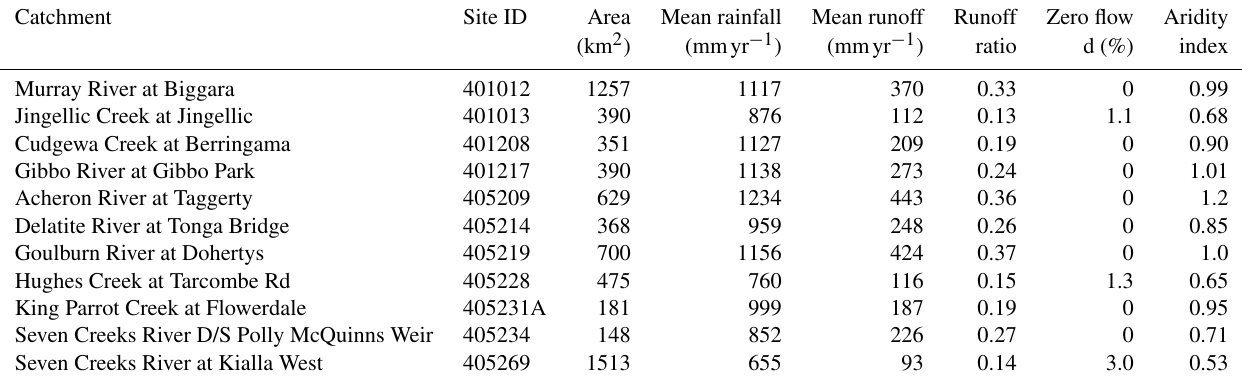
Figure 3. Location of the 11 case study catchments (a) and mean observed streamflow for each month (b) and each year (c) . Box plots in panels (b) and (c) show distributions of mean observed streamflow over the 11 catchments. Table 1. Properties of the 11 case study catchments. Catchment Site ID Area Mean